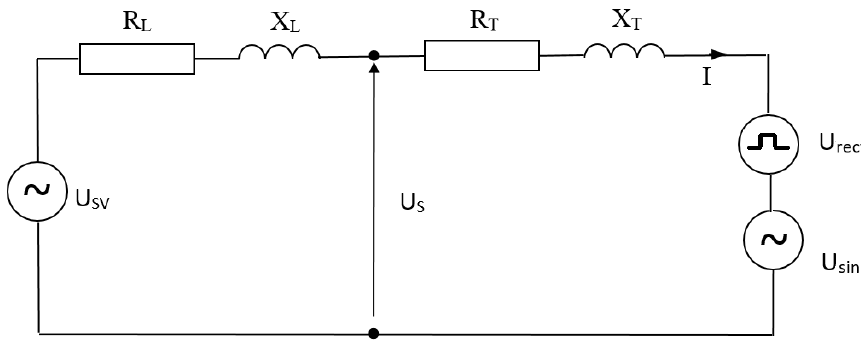
Figure 19. Single-phase equivalent circuit with a two-voltage electric arc model.